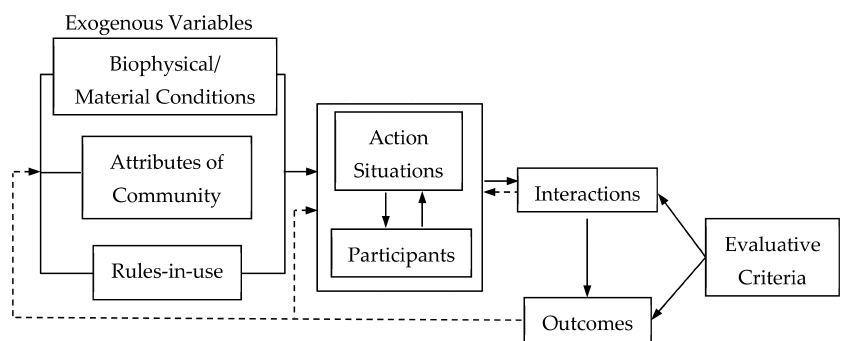
Figure 1. Institutional analytical and development (IAD) framework by Ostrom derived from [40].